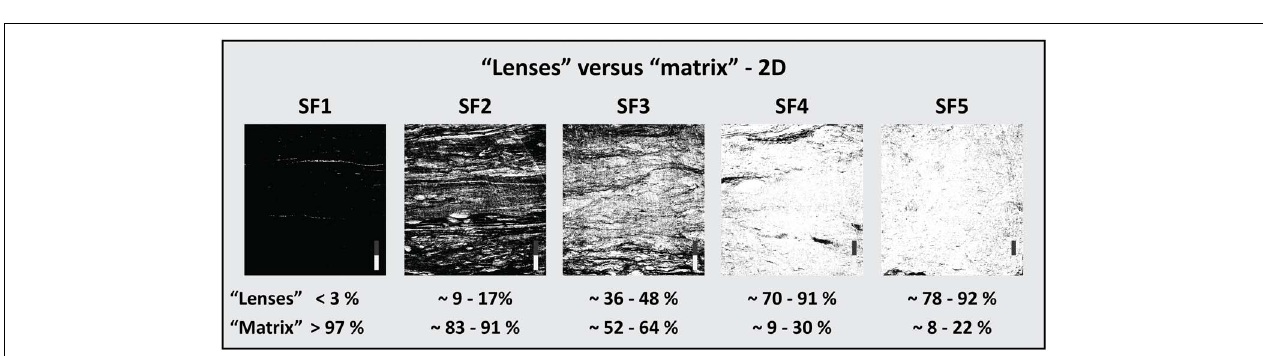
FIGURE 9 | Typical “lenses” versus “matrix” content for each subfacies type. Ranges are indicative and result from representative subfacies type images from Mont Terri drill cores (BGC-2 and BDM-B2). On the binary images: black, “matrix” (clay minerals + minor quartz silt); white, “lenses" (carbonate + quartz content). Binary threshold was set manually with ImageJ. Scale bar = 2